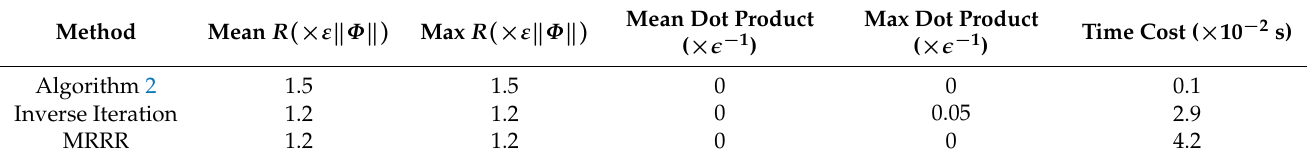
Table 1. Accuracy and orthogonality.